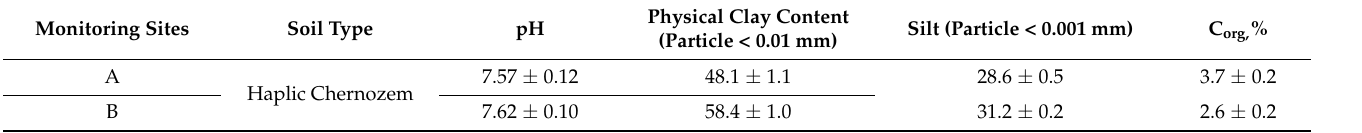
Table 1. Main soil properties at the study